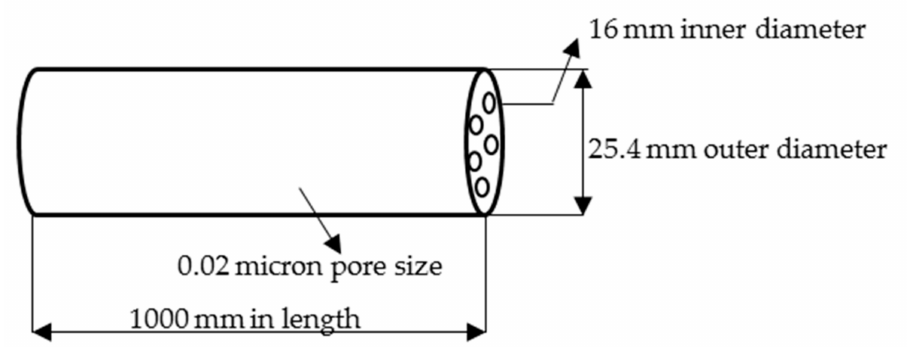
Figure 3. TiO 2 /Al 2 O 3 tubular ceramic membrane and its